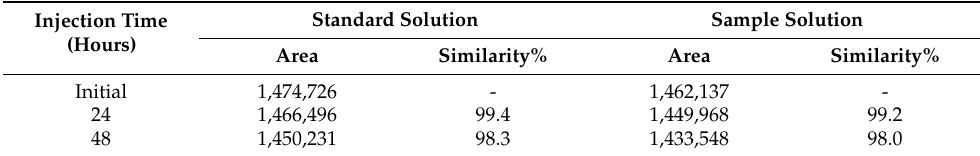
Table 10. Results of Solution